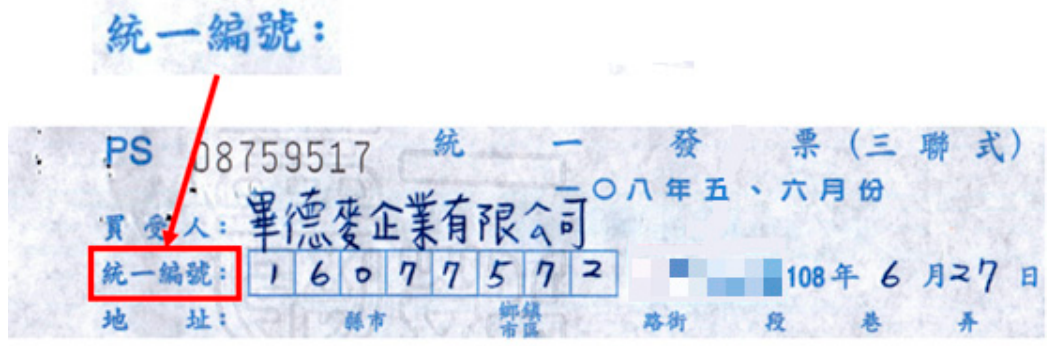
Figure 16. Template matching